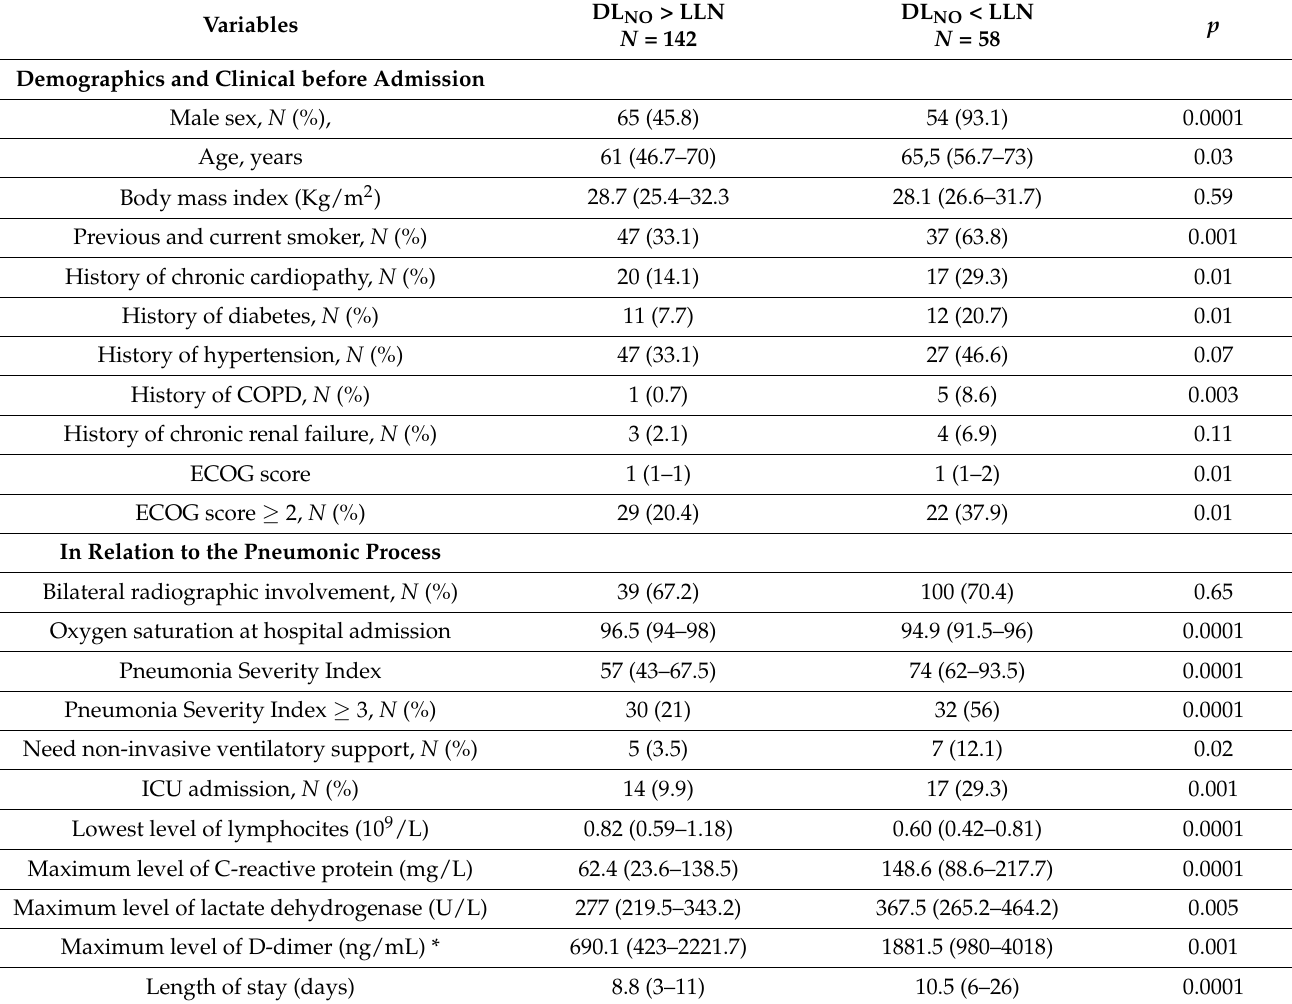
Table 6. Predictive factors for a decrease in DL NO in the univariate